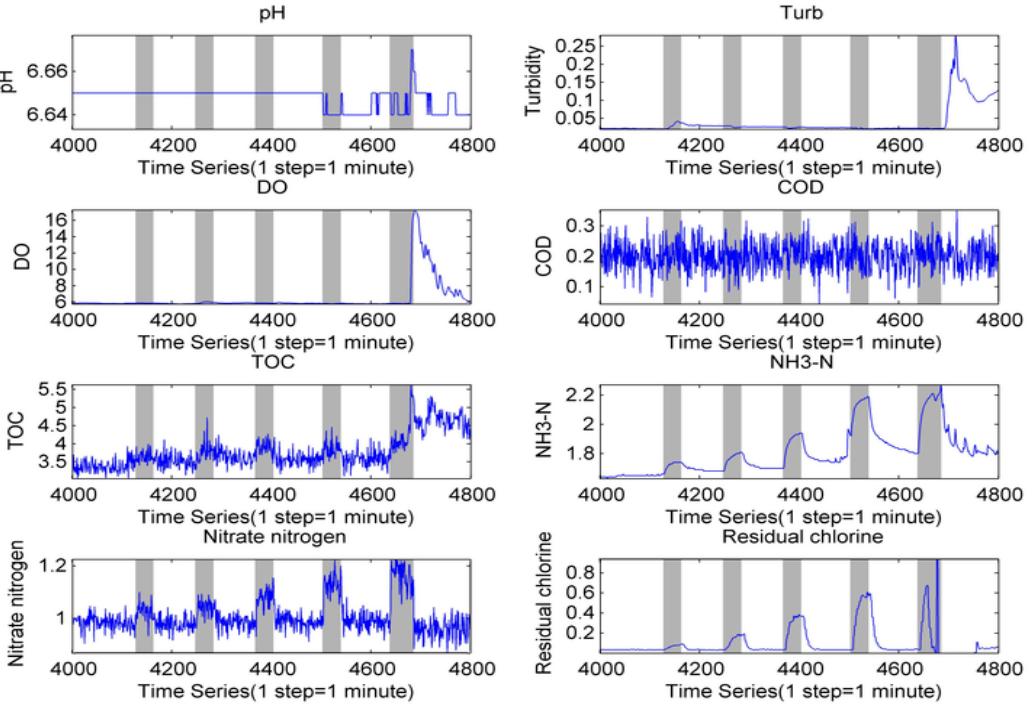
Figure A2. Sensors’ responses for potassium ferricyanide.